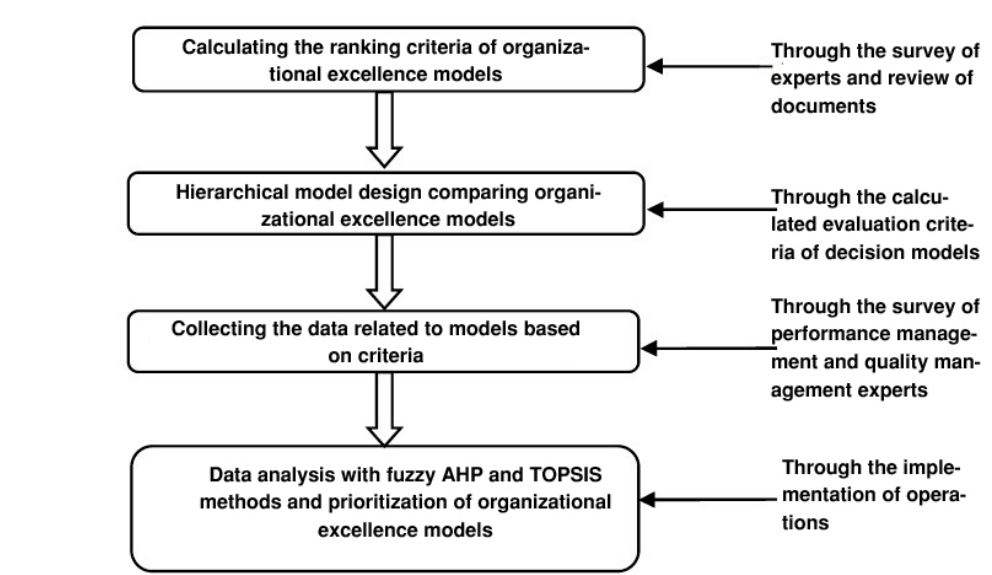
Figure 5. Implementation steps of the research process to determine the best model to evaluate the environmental performance of gas refineries